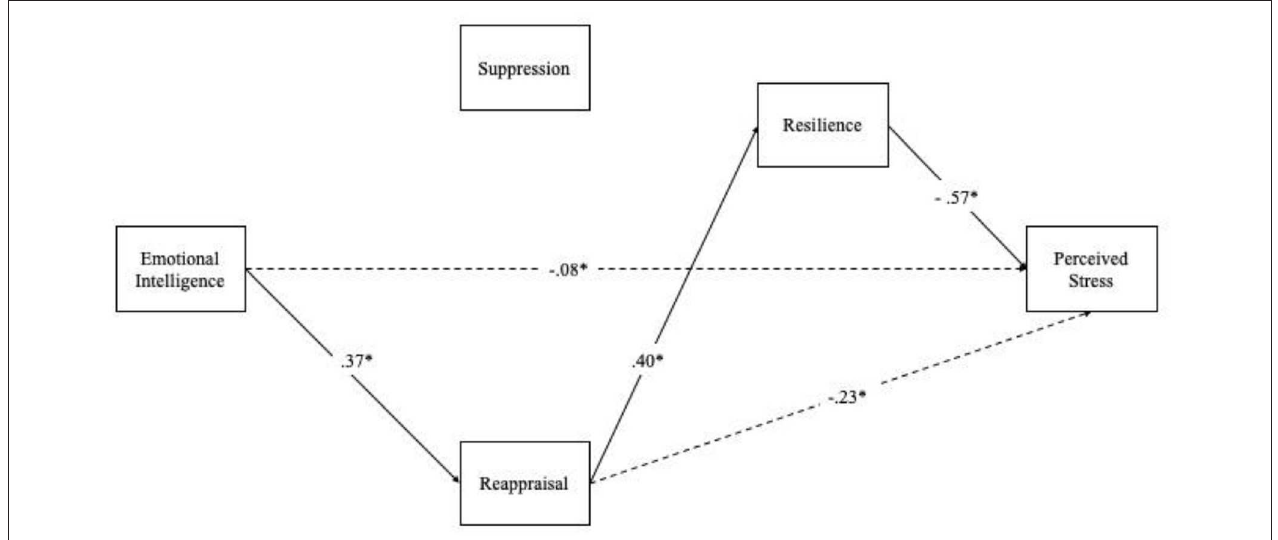
FIGURE 2 | Overview of the fully mediated path model. * < 0.05; only significant paths are shown; dashed lines indicate indirect